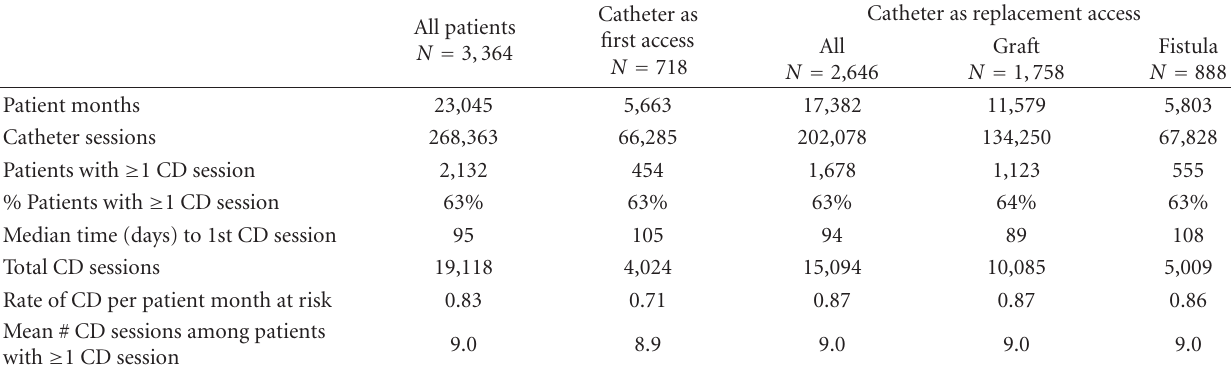
Table 2: Catheter dysfunction ∗ .